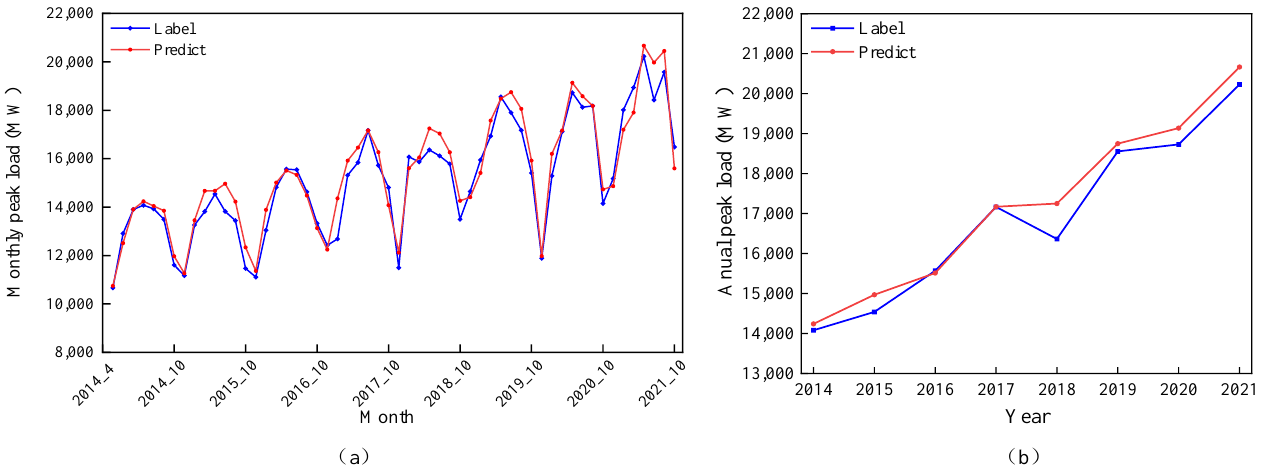
Figure 11. Forecast results in Case 2: ( a ) monthly peak load from April to October (2014–2021); ( b ) annual peak load from 2014 to 2021. Table 5. Predictive performance of the proposed model trained based on monthly data from April to October with various time-series lengths.